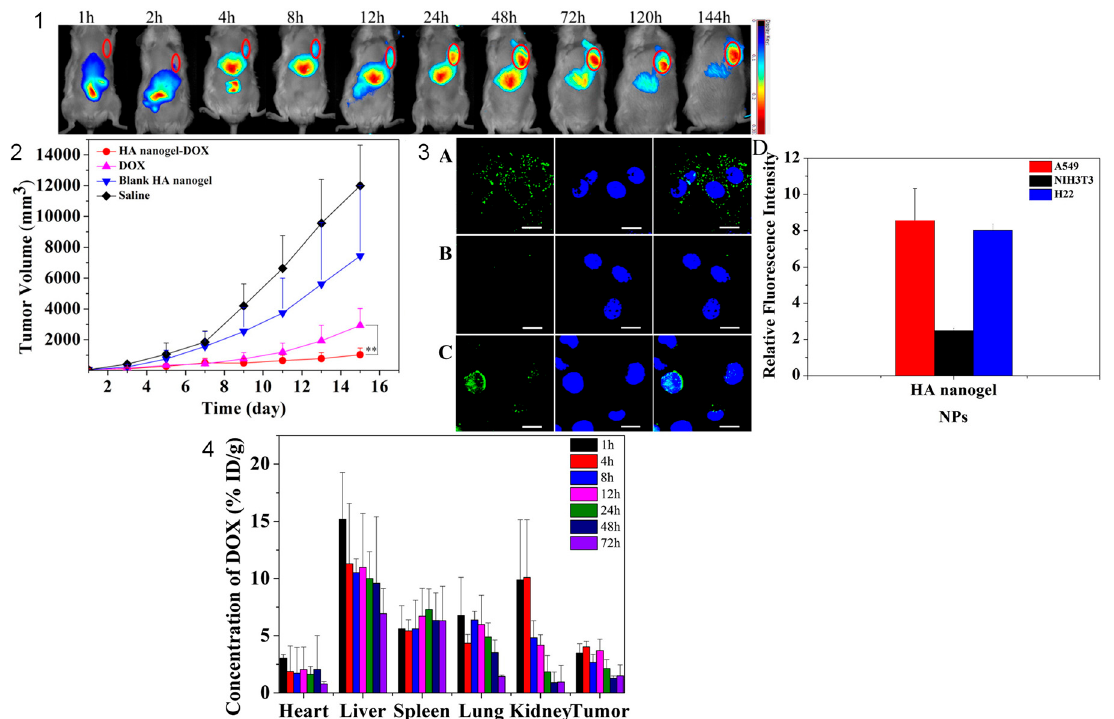
Figure 7. ( 1 ) In vivo near-infrared (NIR) fluorescence imaging of fluorescent Dox-loaded HA-based NG IV administered in induced tumor mice by injection of H22 tumor cells. The fluorescence intensities are represented by different colors according to color histogram. Red circles on the images display the localization of the tumor; ( 2 ) Tumor growth inhibition in H22 tumor-bearing mice that received as treatment Dox-loaded HA-NGs, free Dox, unloaded HA-NGs and saline solution; ( 3 ) Uptake of Dox-loaded HA NGs by cells with high CD44 and CD168 receptor expression ( A ) A549 and ( C ) H22 and low receptor expression cells ( B ) NIH3T3. Fluorescent HA NGs are green-colored in the confocal laser scanning microscope images indicating uptake by HA-receptor cells. The scale bar = 10 µm, ( D ) Flow cytometry analysis of HA NGs incubated with A549, NIH3T3 and H22 cells for 4 h; ( 4 ) Biodistribution of Dox for Dox-loaded HA NGs in H22 tumor-bearing mice at various time points after intravenous injection. (Reprinted with permission from reference [147]. Copyright 2015 Elsevier).